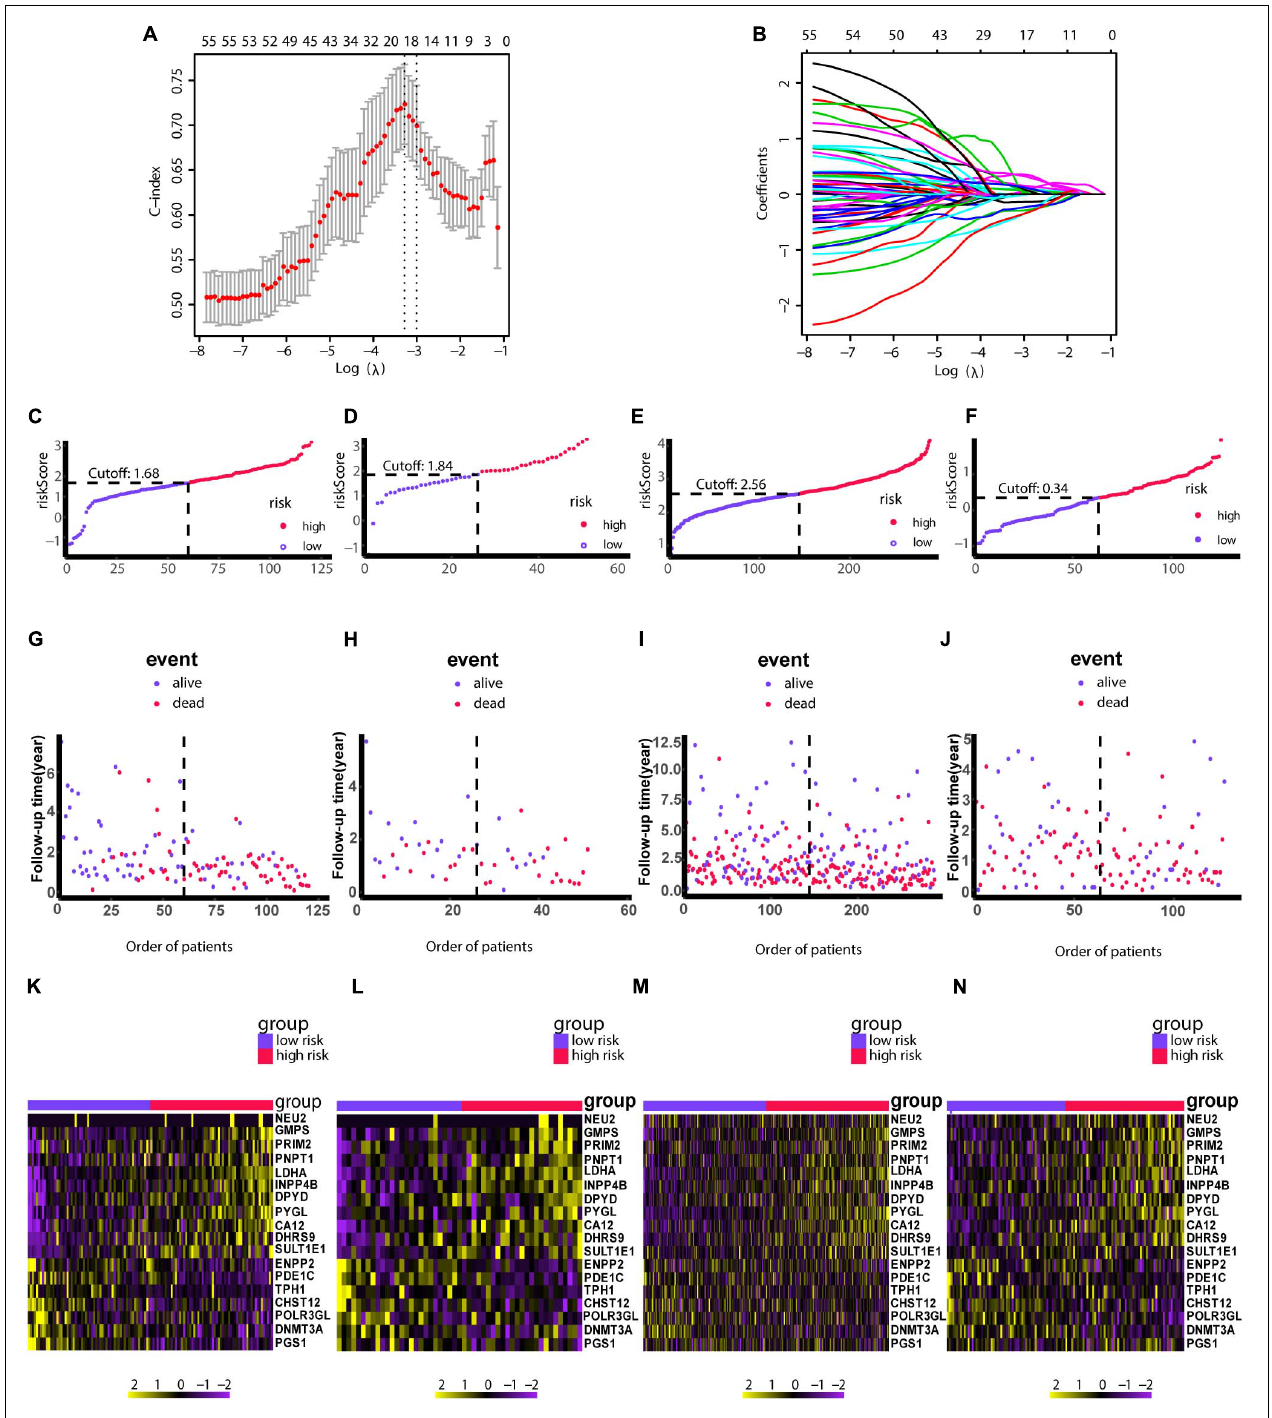
FIGURE 7 | Construction of the risk model using LASSO. (A) Cross-validation based on the C-index to determine the optimal number of genes in the model. (B) Genes in different combinations and corresponding coefficients. (C,G,K) Patients in the training set ( n = 120) were arranged in ascending order of risk scores. (D,H,L) Patients in the internal validation set ( n = 51) were arranged in ascending order of risk scores. (E,I,M) Patients in the GSE729 data set ( n = 125) were arranged in ascending order of risk scores. (F,J,N) Patients in the E-MTAB-6134 data set ( n = 288) were arranged in ascending order of risk scores. (C–F) Patients were divided into different risk levels according to median risk scores in their respective data sets. (G–J) Relationships between survival outcomes and risk levels. Low-risk patients are shown on the left side of the dotted line and high-risk patients are shown on the right side. (K–N) Heat maps for genes in the model. LASSO, least absolute shrinkage and selection operator. P < 0.05 was defined as statistically